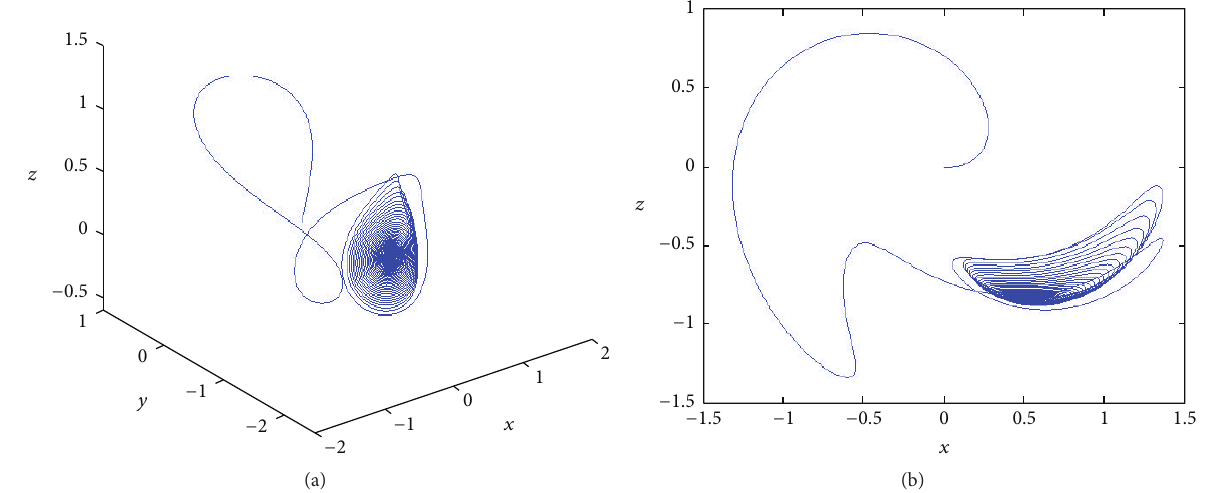
Figure 6: Phase diagram of system (15) with 𝑎 = 0.4 , 𝑏 = 3 , and 𝑐 = −0.8 .